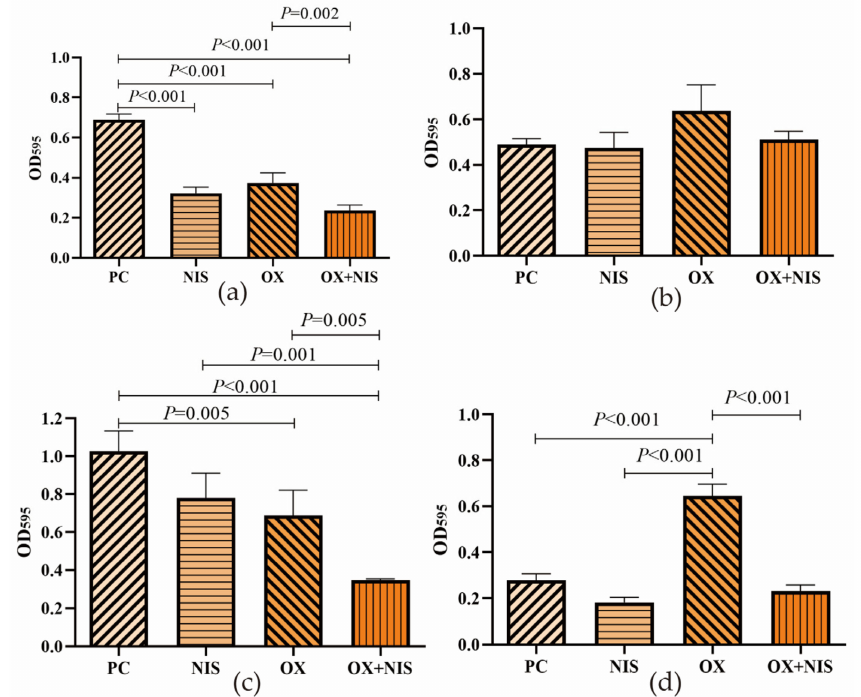
Propidium iodide (PI) is a fl uorescent probe that can only penetrate cells with dam- aged cell membranes and bind to nucleic acids, so detecting changes in fl uorescence in- tensity can re fl ect the integrity of cell membranes. As shown in Figure 4d,e, the percent- ages of PI-stained cells in NIS, OX, OX + NIS treated Yn2020070 were 19.0%, 58.2%, 81.7%, separately, while 16.8%, 51.2 %, 33.2% for ATCC25923. It is suggested that OX + NIS may Figure 3. Biofilm producing of MRSA treated with OX, NIS and OX + NIS, with control of PC damage the integrity of cell membrane. (positive control). ( a ) Yn2020043; ( b ) Yn2020051; ( c ) Yn2020070; ( d ) ATCC25923.